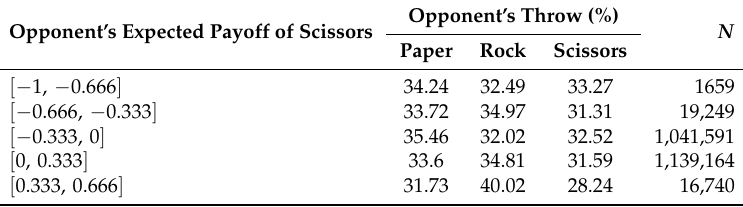
Table A7. Opponents’ Response to Expected Payoff of